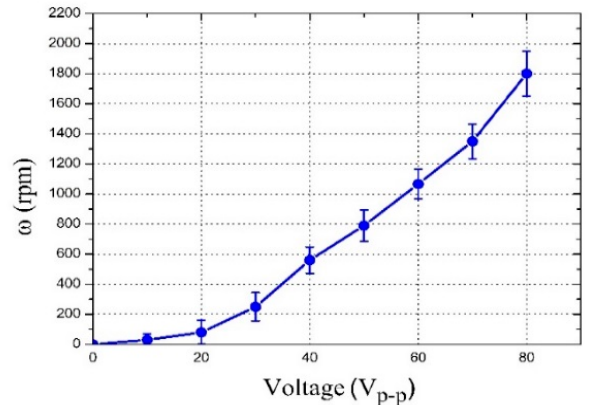
Figure 9. Relationship between the rotation speed of the diatom cells and the voltage, showing that the former can be tuned by the applied peak-to-peak voltage.